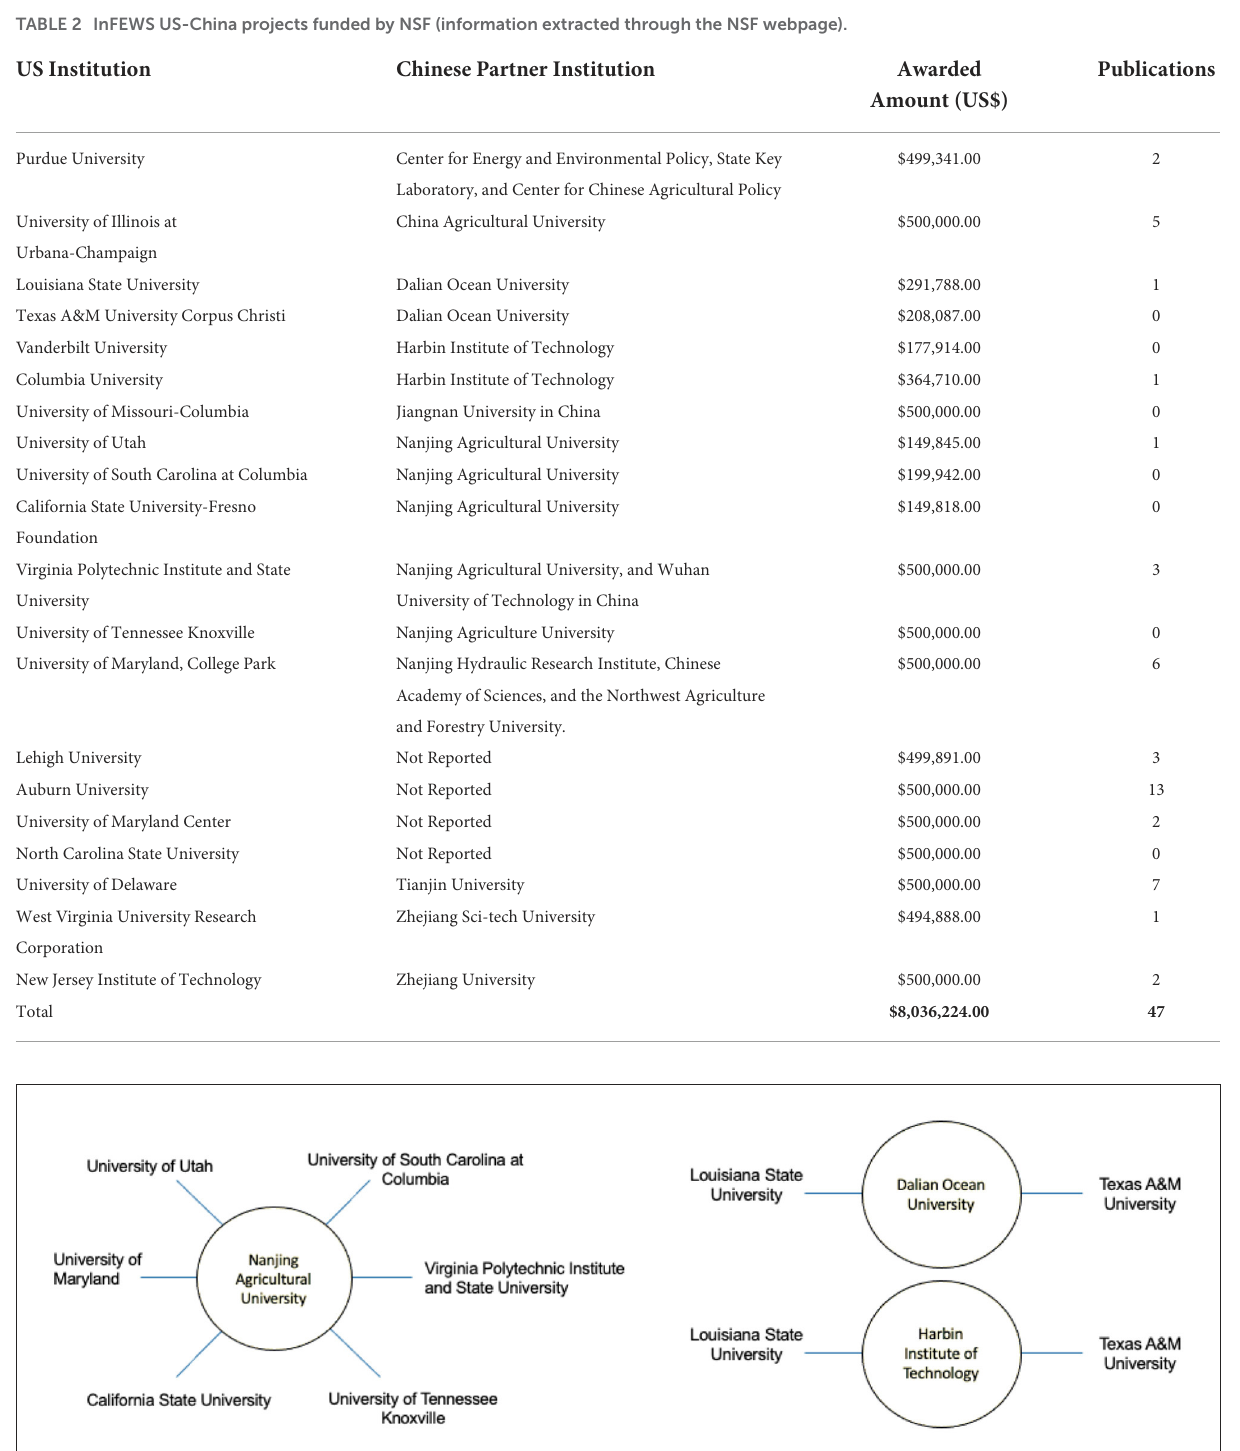
of the FEW interdependencies, although few if